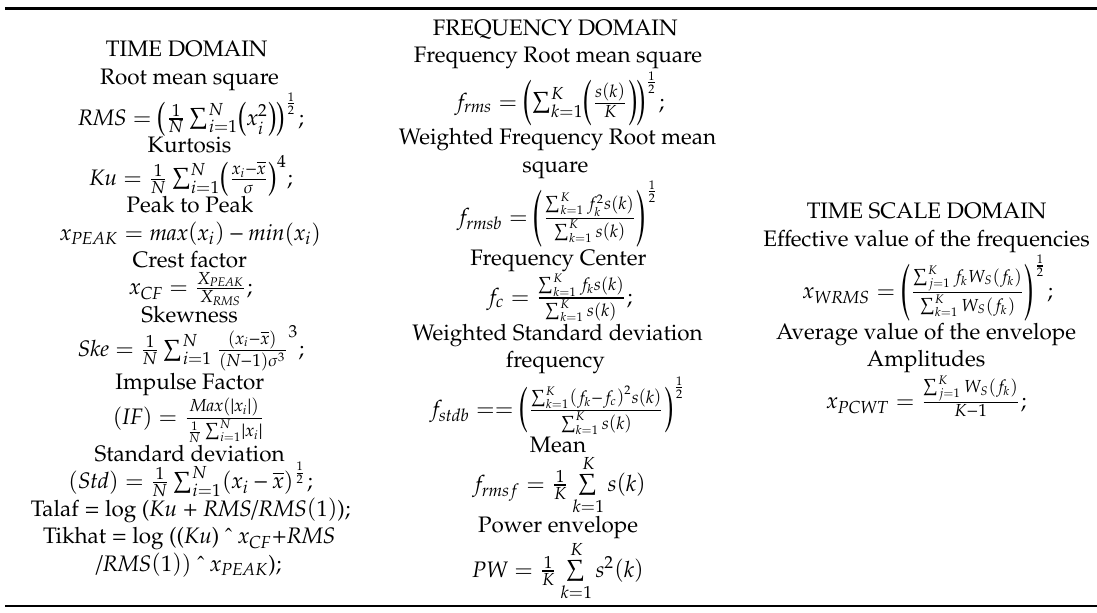
Table 2. Computed features. x is the sequence of samples obtained after digitizing the time domain signals, x i is a signals series for i = 1, 2..., N. W S ( f k ) corresponds to the spectral density of the max coe ffi cients of the continuous wavelet transform. s ( k ) is a spectrum for k = 1,2 ... K , K is the number of spectrum lines, f K is the frequency value of the k th spectrum